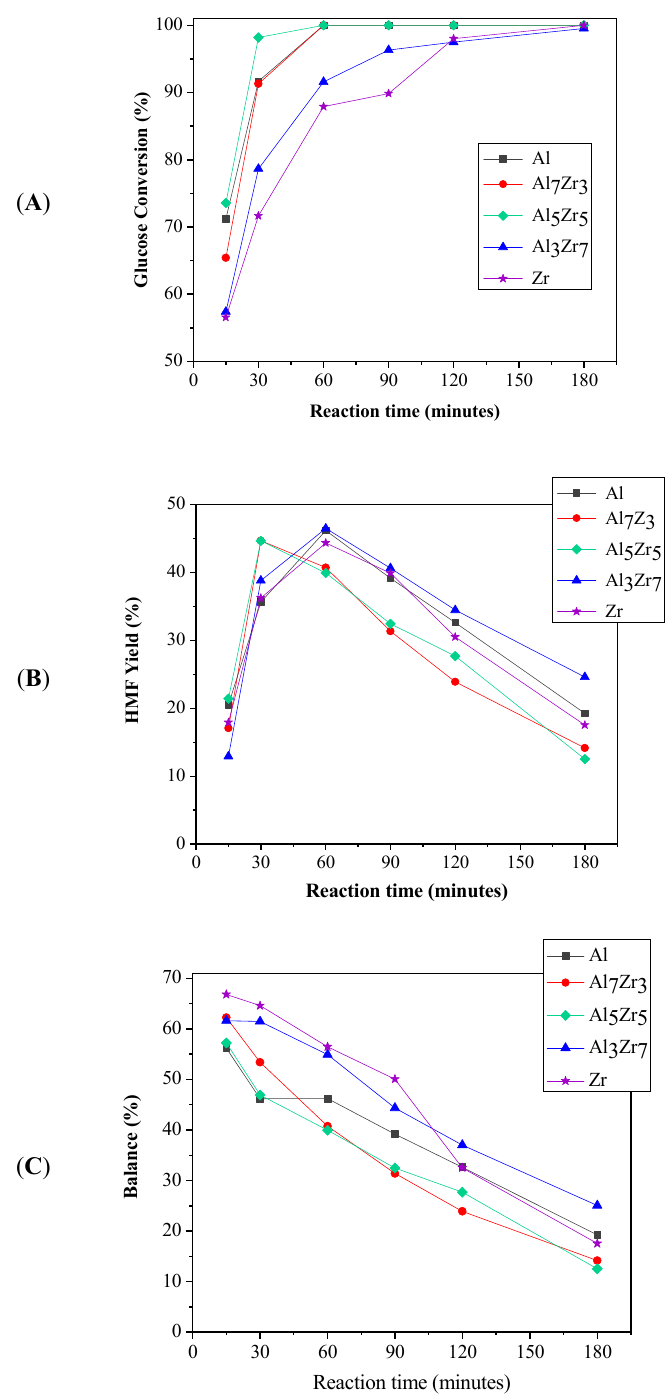
Figure 6. Glucose conversion ( A ), HMF yield ( B ), and carbon balance ( C ) as function of reaction time in the presence of Al, Zr, and Al x Zr y catalysts (175 °C, 0.65 g CaCl2 ·g aq.sol. − 1 and glucose/catalyst weight ratio of 3).